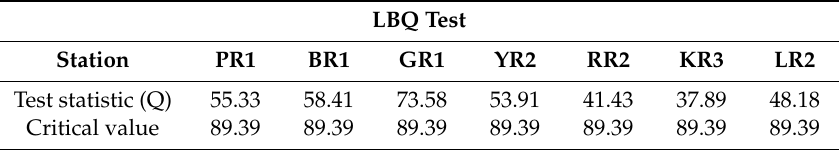
Figure 3. The ACF and PACF of residuals at the PR1 station in the Pozi River basin. Table 4. Ljung–Box–Pierce (LBQ) statistics for the residuals at each basin. Table 4. Ljung–Box–Pierce (LBQ) statistics for the residuals at each basin.